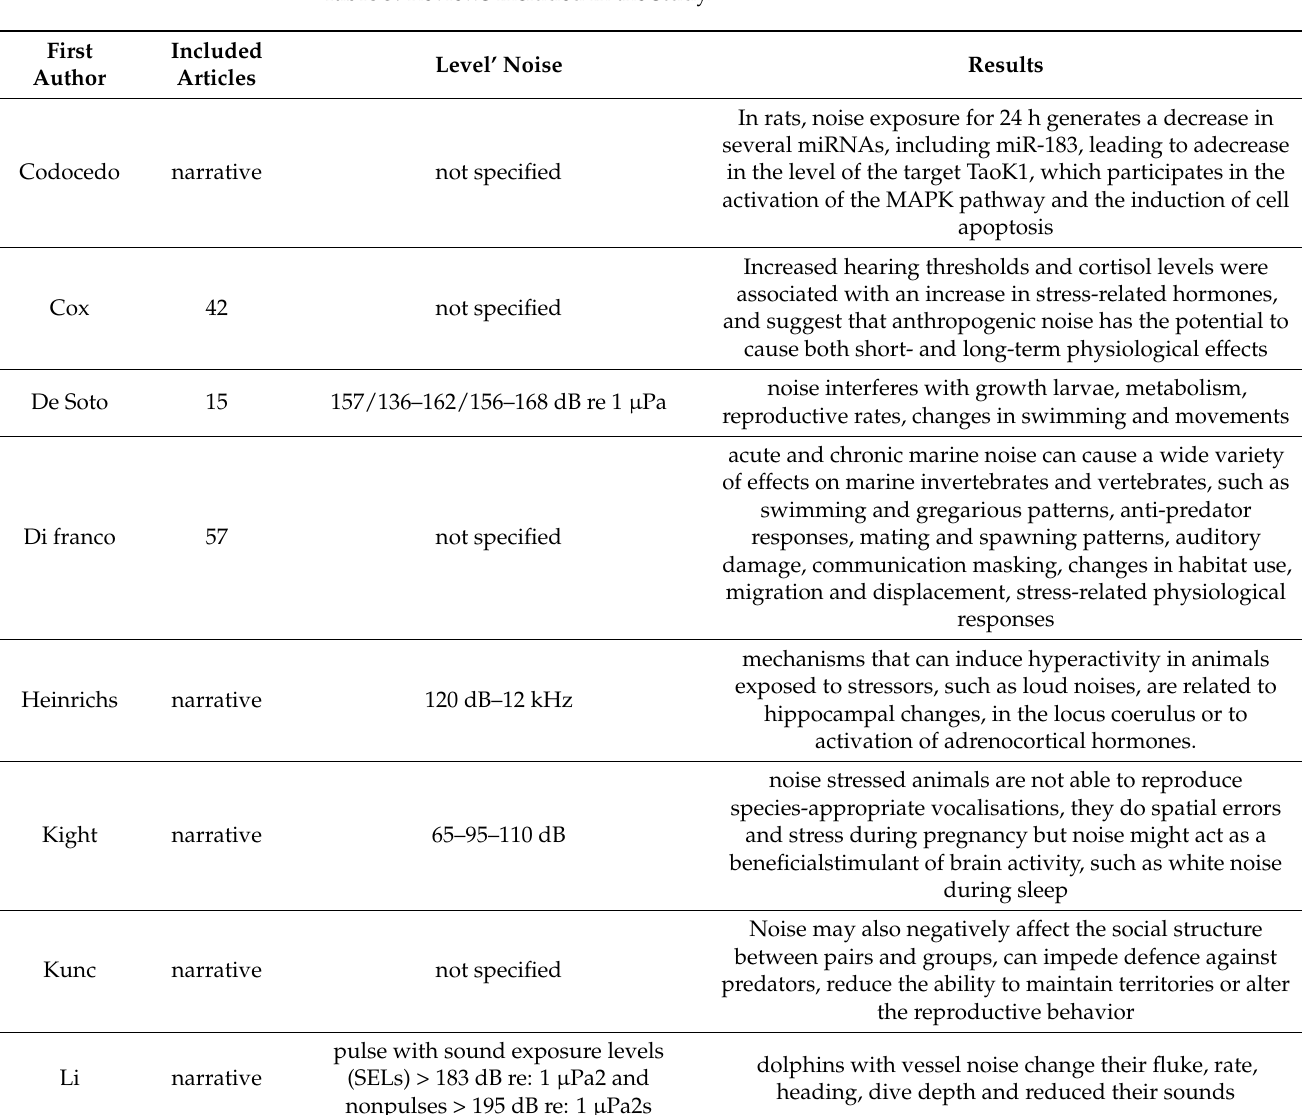
Table 3. Reviews included in the